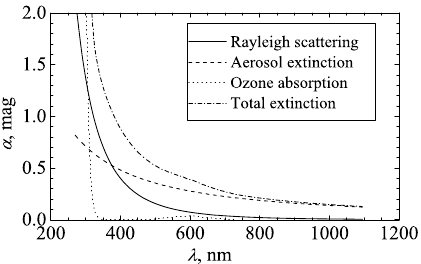
Fig. 1. Dependence of the mono- chromatic extinction coefficients on wavelength for different atmospheric extinction components. Atmosphe- ric extinction at zenith is calculated using the typical atmospheric extinc- tion parameters for the Mol˙etai Ob- servatory (see the